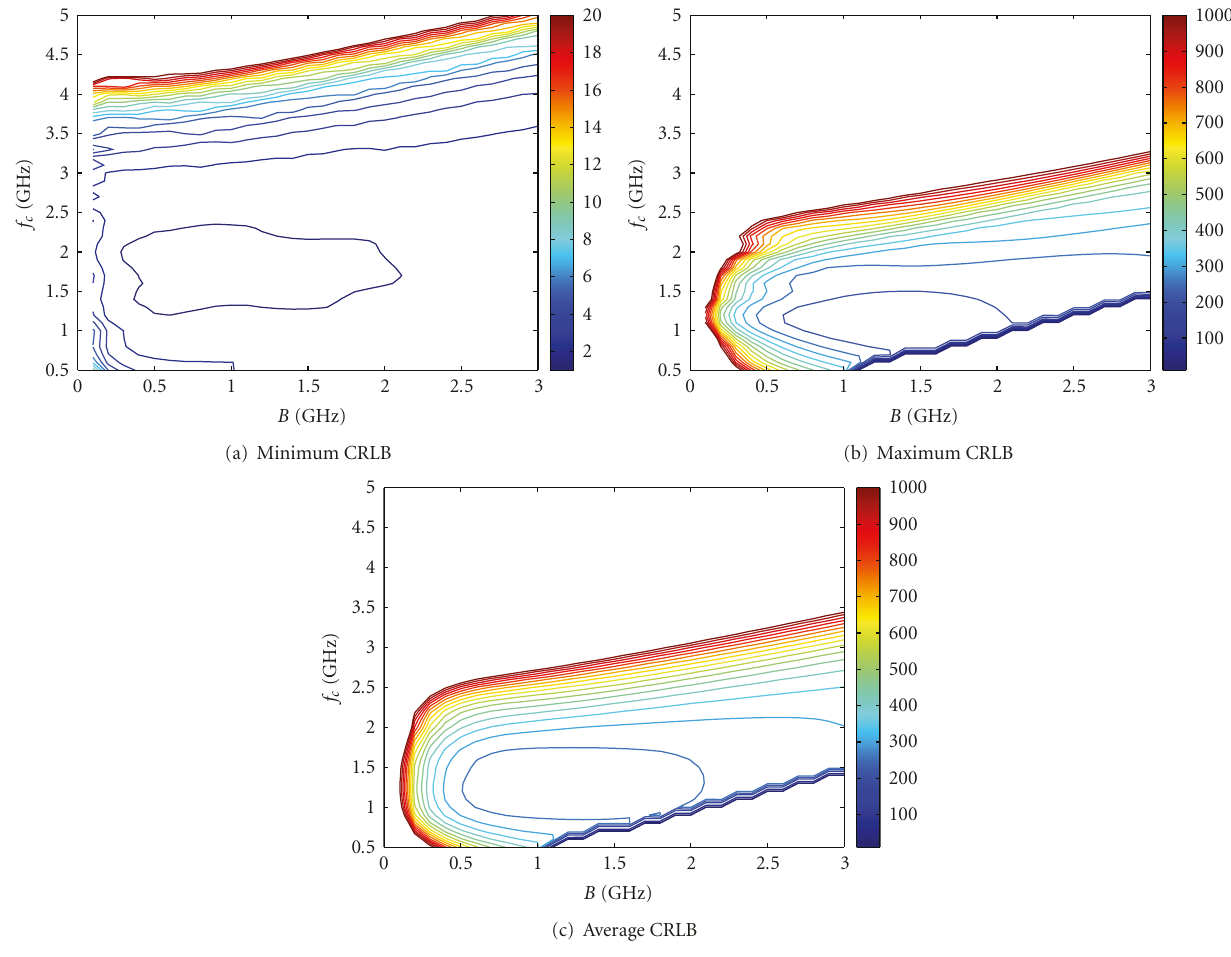
Figure 3: CRLB for (cid:3) r over Θ as a function of ( f c , B ).